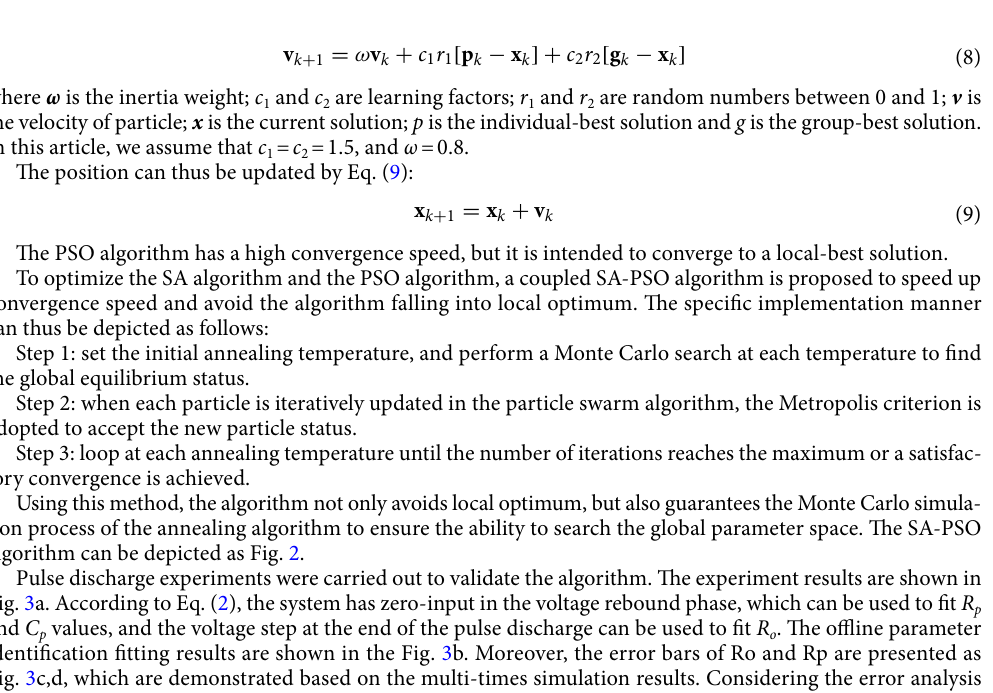
Figure 2. Procedure of the proposed PSO-SA